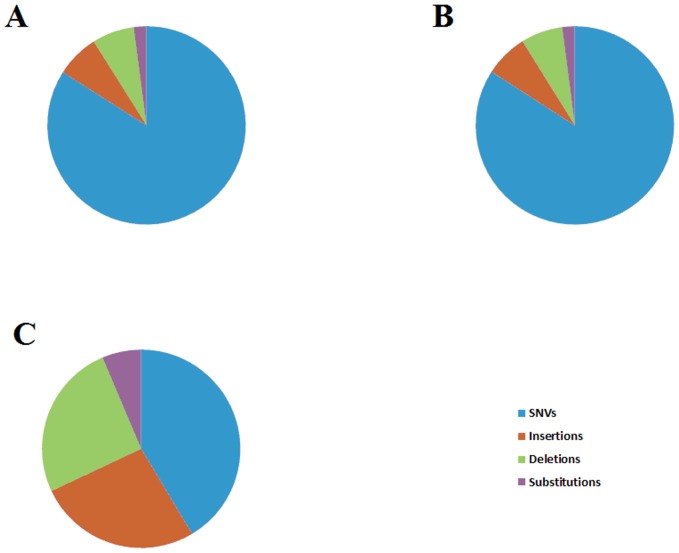
Changing proportion of SNVs, insertions, deletions, and substitutions across samples.Variants that passed QC and that were called at any read-depth in genes and gene-coding regions were selected. The proportions of these variant types changed when looking at those unique to the node, with much higher proportions of insertions, deletions, and substitutions being found. A, Tumor; B, Node; C, unique to node.